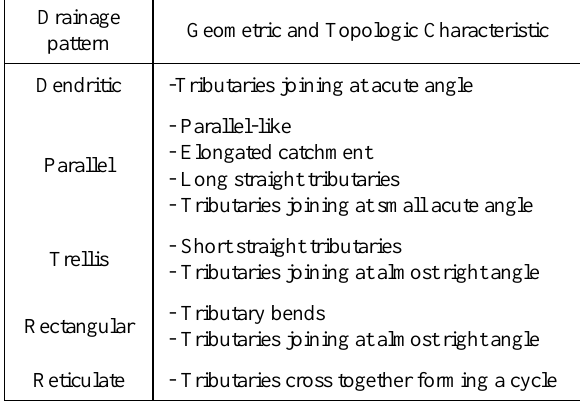
Table 1. Drainage pattern characteristic